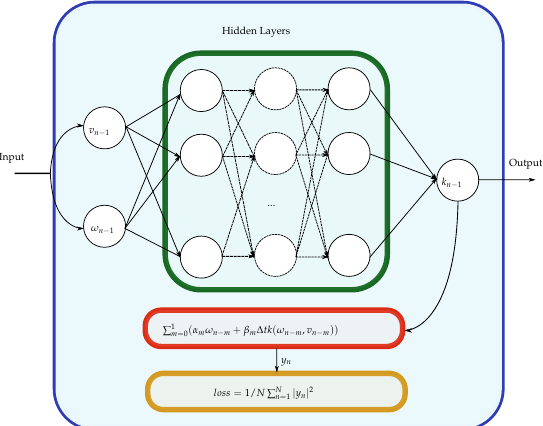
Figure 1. Diagram of the implemented multi-step neural networks (MSNN) with the exogenous input. During testing, the output and input of the network are fed to an ordinary differential equation solver. The output of the solver will be the new input of the network ω